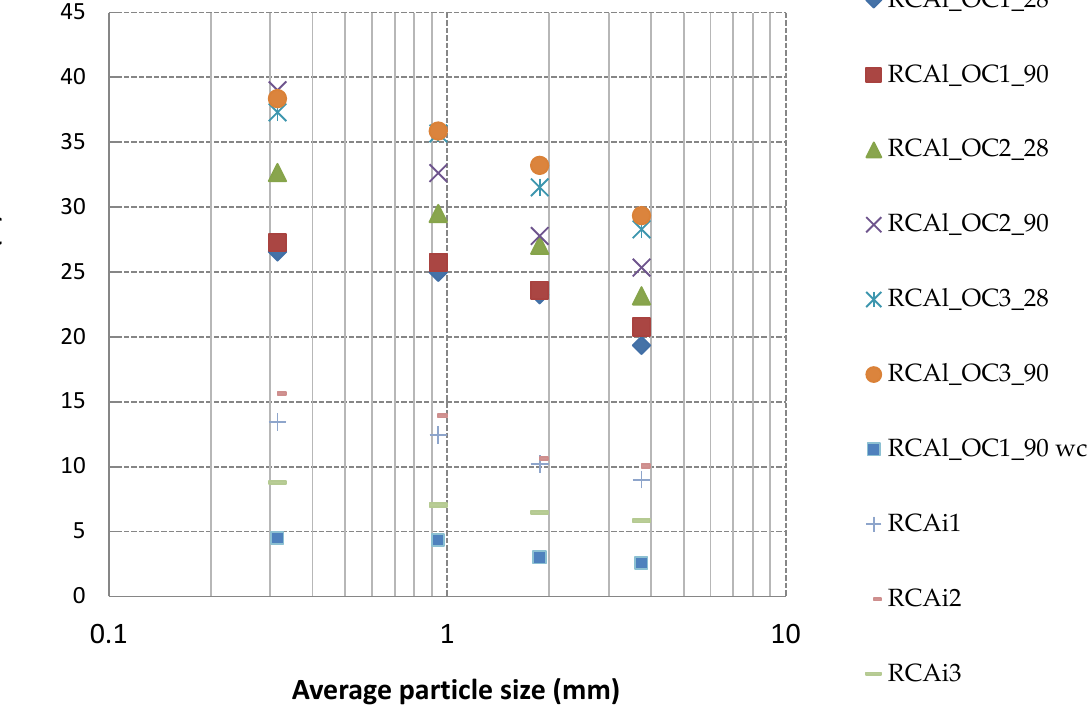
Figure 8. SFSA as a function of the average particle size of the four granular classes for all studied RCA.